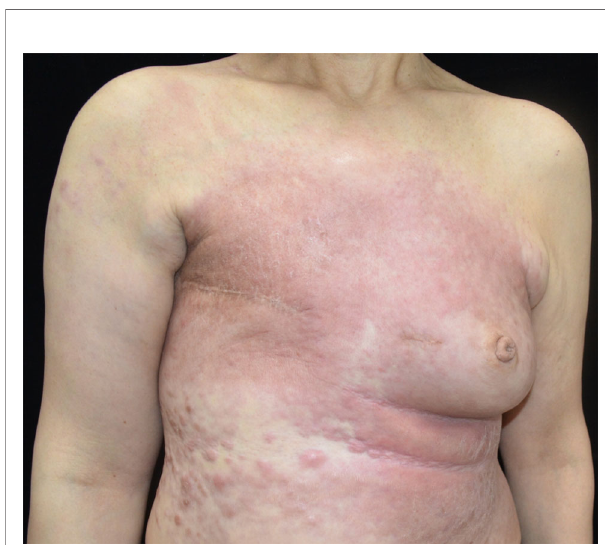
FIGURE 1 | Clinical picture of the patient. Elevated, keloid-like, fi ne nodules coalescing into diffuse sclerodermoid plaques in a background of erythema were found on the right upper arm, chest wall, and